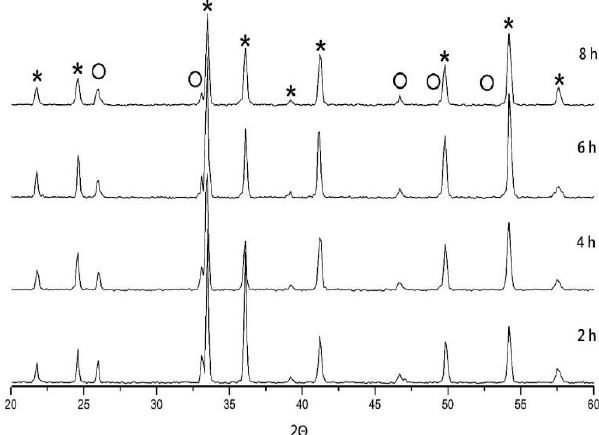
Figure 2. XRD analysis of MNT ceramics sintered at 1350 °C with varied holding time. ( ＊ : MNT, ○ : MNT2).